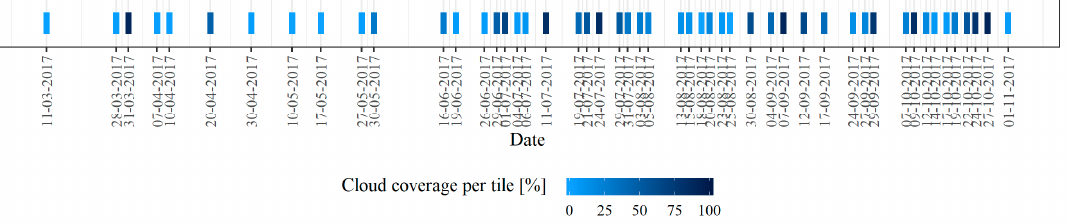
Figure 2. Temporal availability of the Sentinel-2 time series data used in this study. Colors indicate cloud coverage per tile.